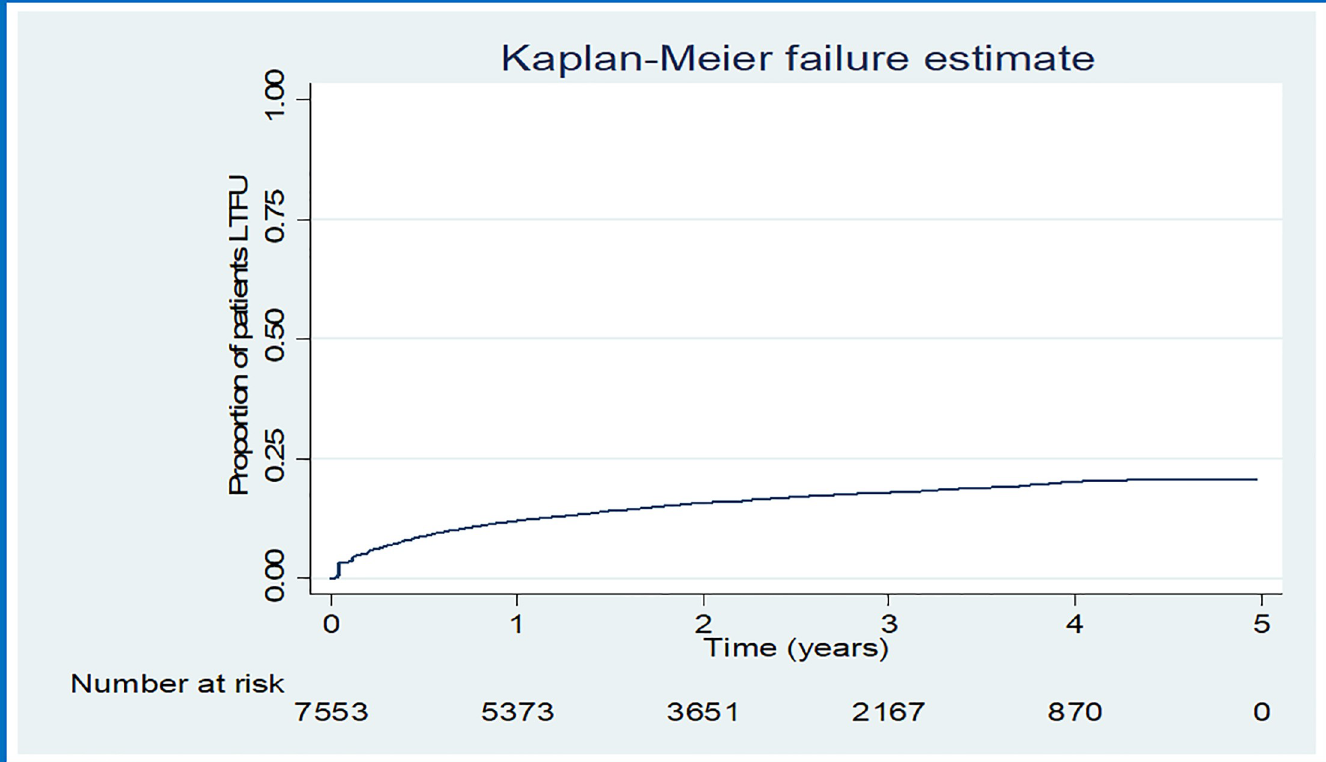
Fig 2. Overall proportion of patients lost to follow up in the study